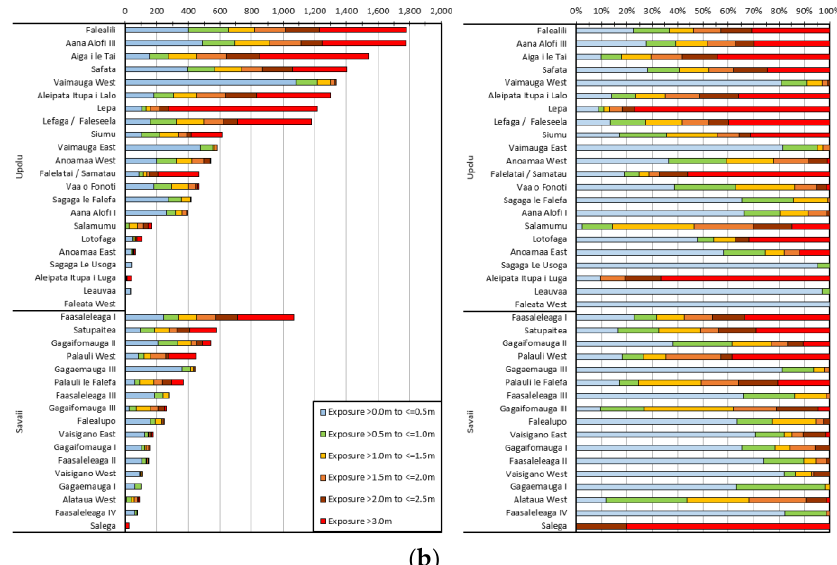
Figure 4. Number of buildings and proportionate distribution ( a ), and length of roads and proportionate distribution ( b ), exposed to different flow depths for each district of the whole country for a 2009 SPT 50 m scenario.